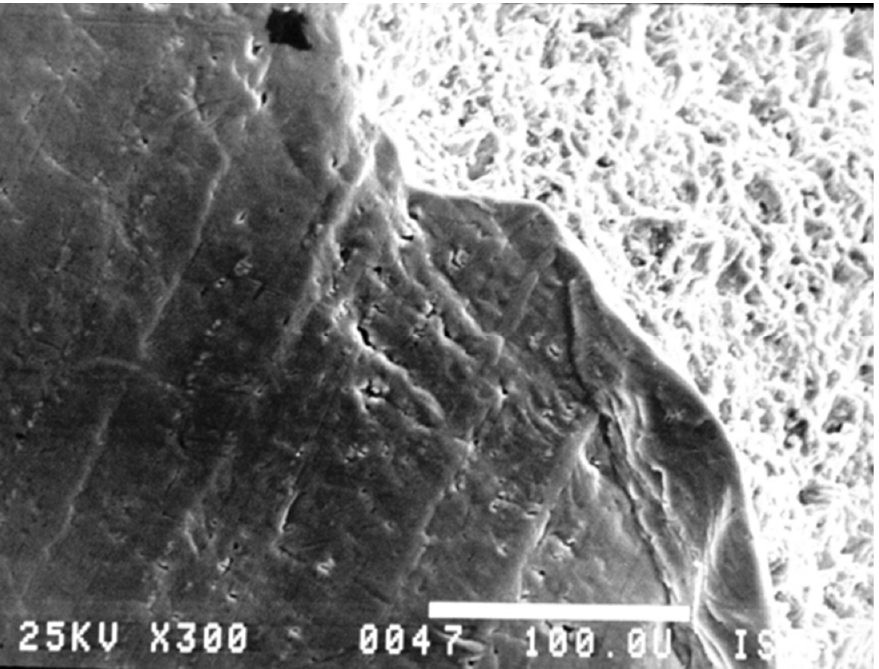
Figure 16. Results of SEM photo of the surface of the test object, compressive tensile loading with microcracks near the fracture surface, t = 0.35%, N = 24,470.